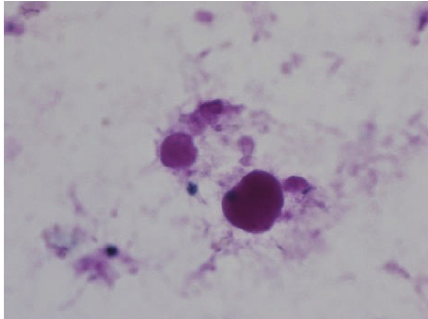
Figure 4: PAS-stained BAL preparation showing PAS positive globular material and supporting a diagnosis of PAP (magnification